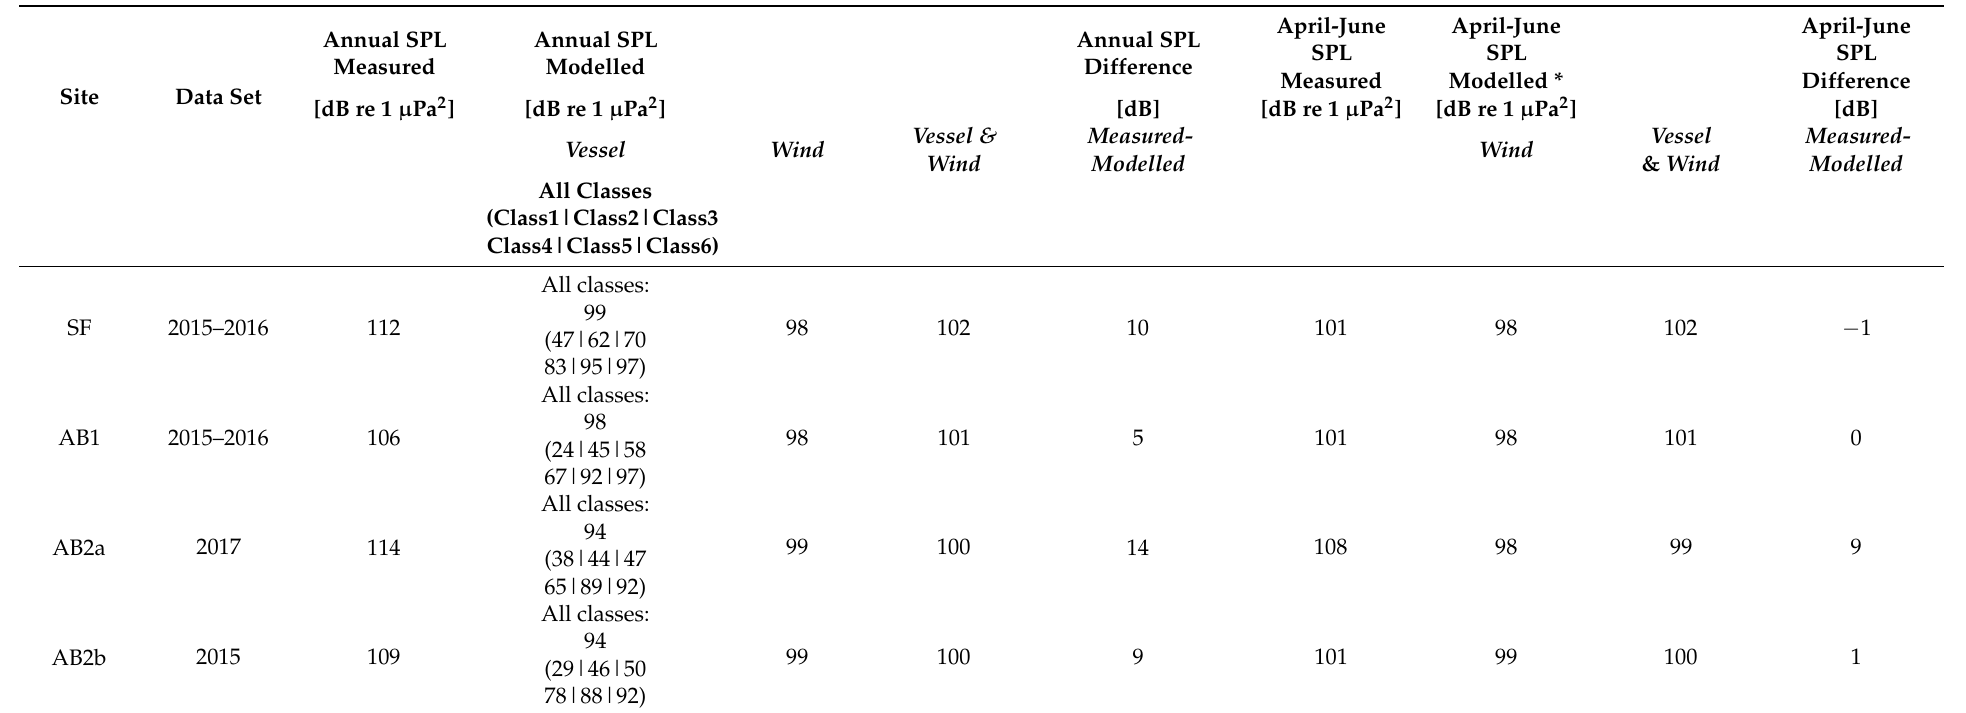
Table 3. Comparison of measured sound pressure level (SPL), modelled vessel SPL, and modelled wind SPL for each site over a period of a year and over April–June. All SPL values are mean-square sound pressure, averaged over 12 and 3 months (April–June), respectively. Vessel and wind noise model results are based on data from 2015. Measured SPL were calculated from data recorded in or nearest to 2015 and integrated over 30 Hz–2 kHz. * We assumed that vessel noise SPL over April–June was equal to vessel noise SPL over the whole